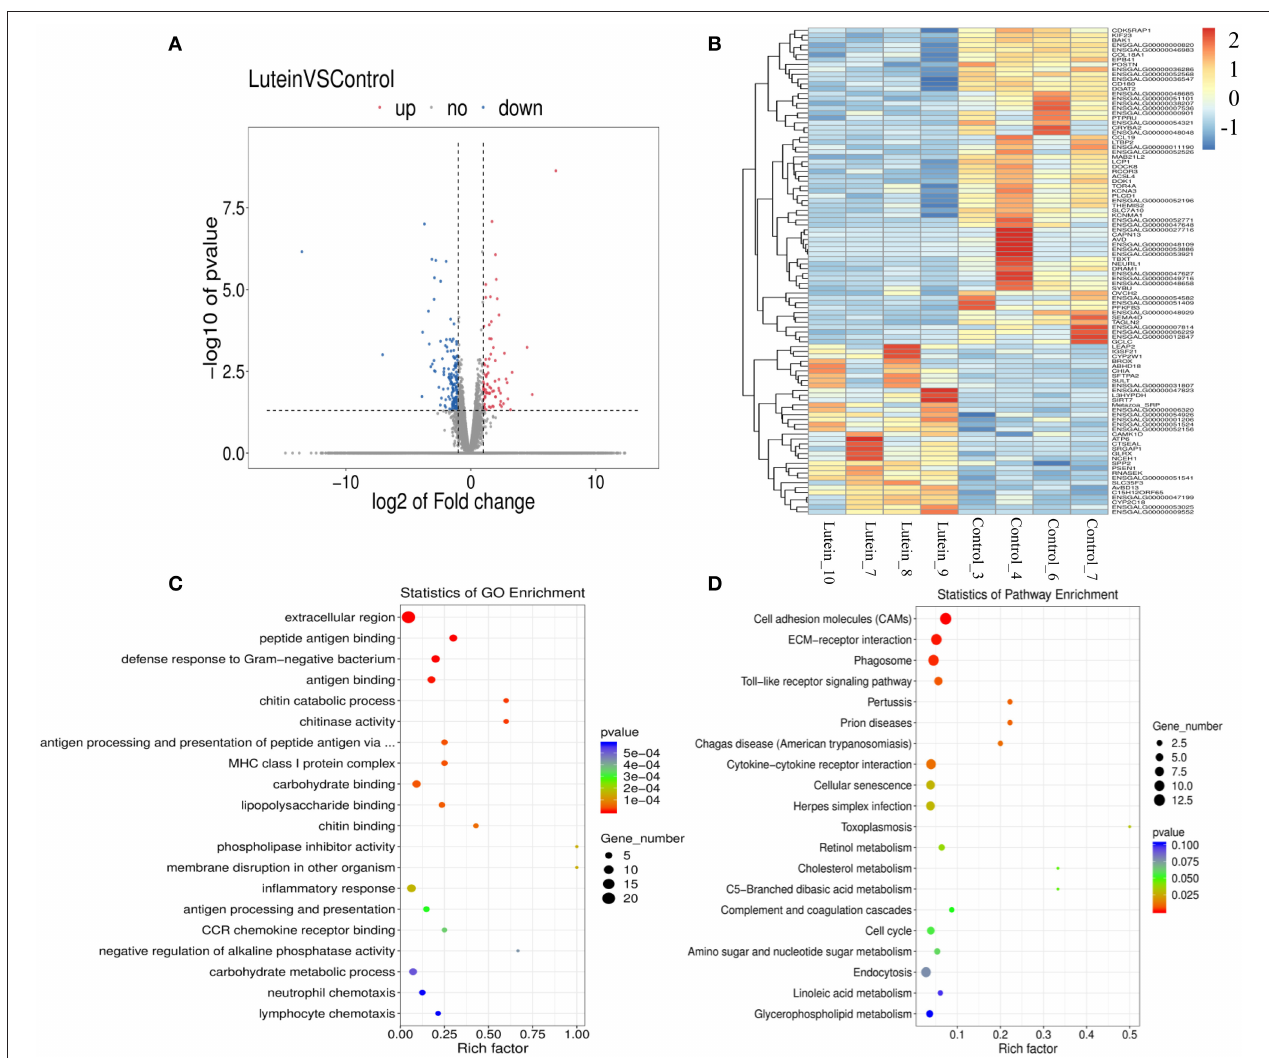
FIGURE 3 | Expression profiles of differentially expressed genes (DEGs) and GO and pathway analysis. (A) Volcano plot of the significant differences in the DEGs. The horizontal and vertical axes represent the fold-change (FC) and P-value , respectively (FC > 2 or FC < 0.5 and P-value < 0.05). (B) Heatmap of the expression profiles of all DEGs. The rows and columns represent the DEGs and samples, respectively. The color from blue to red indicates the log 10 (FPKM + 1) values were from small to large, the red color indicates a high expression level, and the blue color indicates a low expression level. (C) Top 20 GO enrichment terms of all DEGs. (D) Top 20 KEGG pathways of all